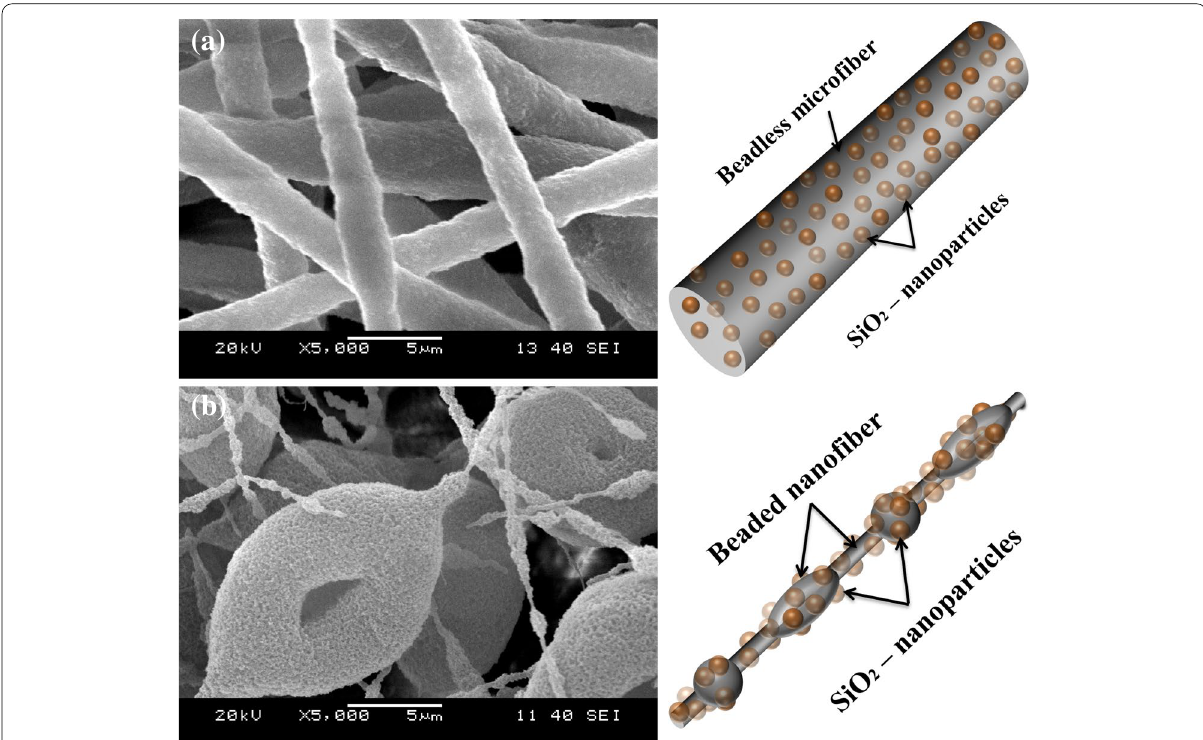
Fig. 2 SEM images of SiO 2 –incorporated PHBV fibers; a beadless microfibers from a 12 wt.% PHBV solution; b beaded nanofibers from a 4 wt.% PHBV solution; c , d schematics of each